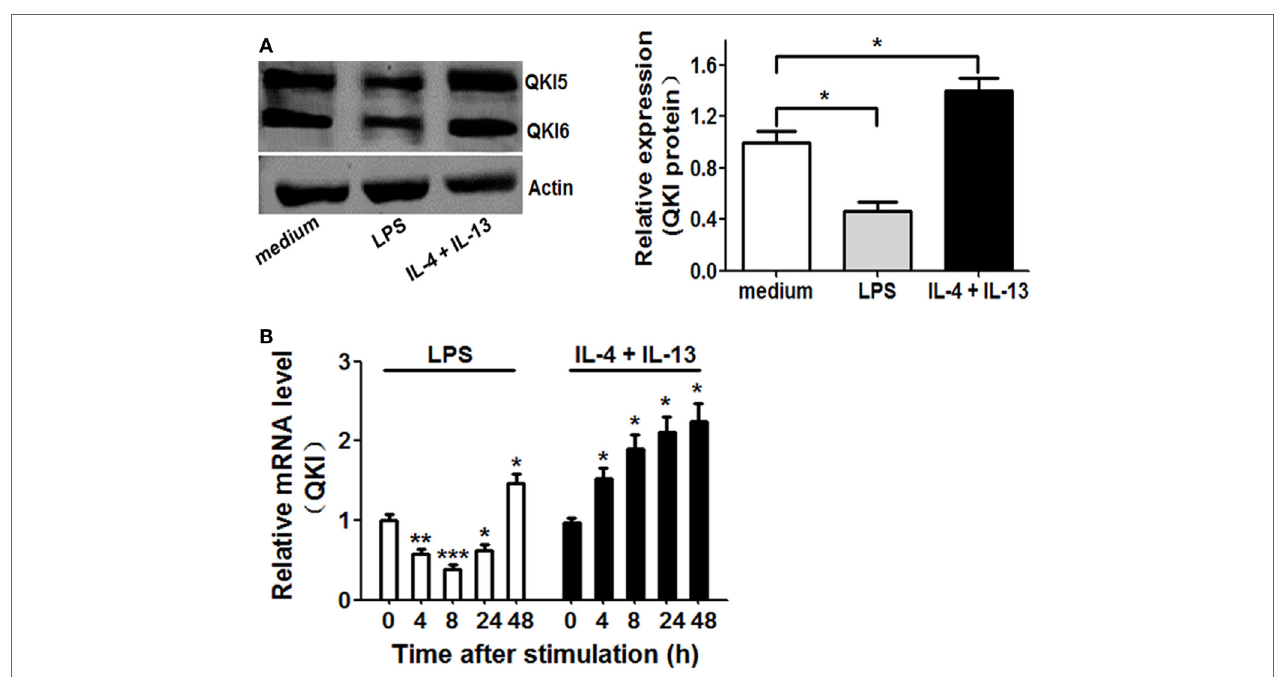
FigUre 1 | Expression of quaking (QKI) in differently polarized macrophages. (a) Peritoneal macrophages from wild-type (WT) mice were stimulated with 1 µg/ml lipopolysaccharide (LPS) or IL-4 (20 ng/ml) plus IL-13 (20 ng/ml) for 16 h. Total cell lysates were subjected to western blot to analyze the protein expression of QKI, with actin as an internal control. One representative immunoblot is shown (on the left). Graphs (on the right) are representative quantification of the band intensity for immunoblots from three independent experiments. (B) Real-time PCR analysis of QKI mRNA in mouse macrophage RAW 264.7 cells left untreated or stimulated for 4, 8, 24, or 48 h with 1 µg/ml LPS or IL-4 (20 ng/ml) plus IL-13 (20 ng/ml). Results presented relative to those of untreated macrophages, set as 1. Actin served as an internal control. All bars represent the mean of measurements from three independent experiments, and the error bars indicate ± SEM. * p < 0.05, ** p < 0.01, *** p <